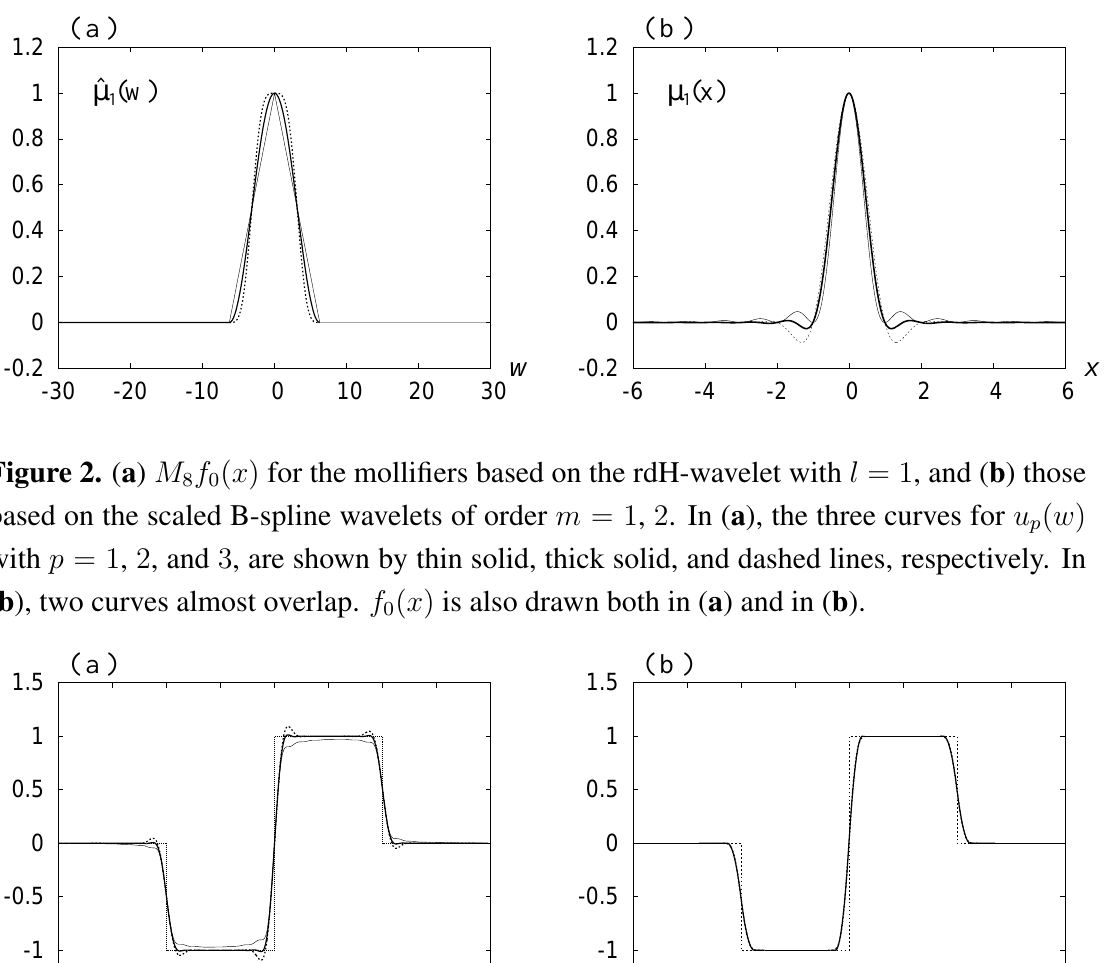
( w ) and µ ( x ) for the mollifiers based on the rdH-wavelets with l = 1 . The Figure 1. ˆ µ 1 1 ( w ) with p = 1 , 2 , and 3 , are shown by thin solid, thick solid, and dashed three curves for u p lines, respectively.